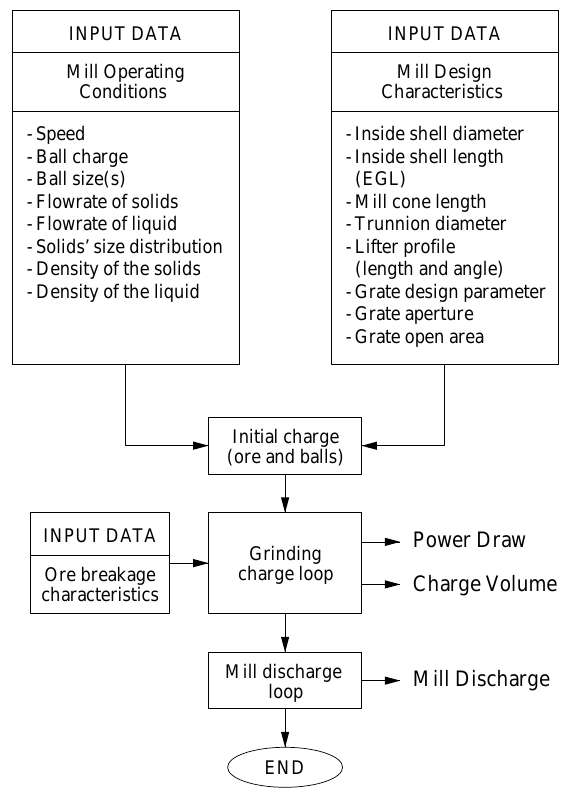
Schematic Flow Sheet of the AG/SAG Mill Model.